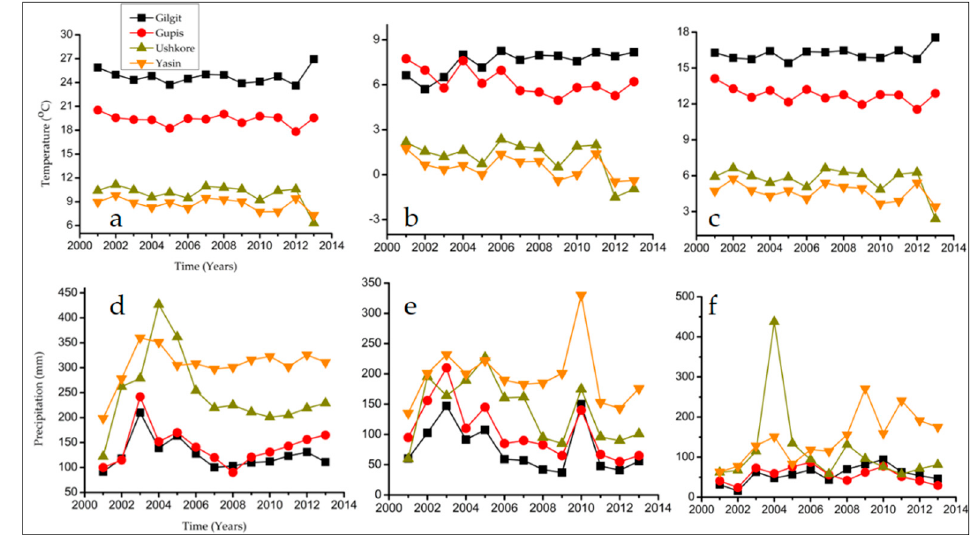
Figure 4. Temperature and precipitation from meteorological stations in the Gilgit River Basin; ( a – c ) for temperature and ( d – f ) for precipitation. ( a ) Maximum temperature; ( b ) minimum temperature; ( c ) mean temperature; ( d ) annual precipitation; ( e ) summer precipitation, and ( f ) winter precipitation.